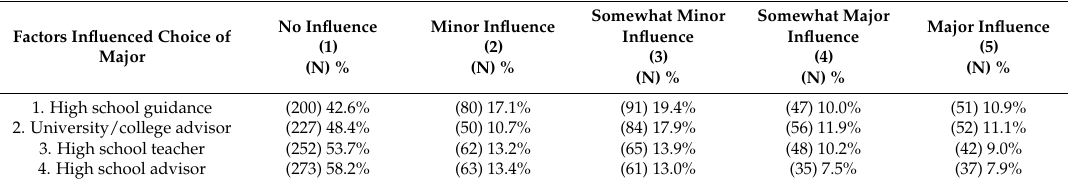
Table 4. Factors Influenced Choosing Major for first year students (related to student academic advising issue).